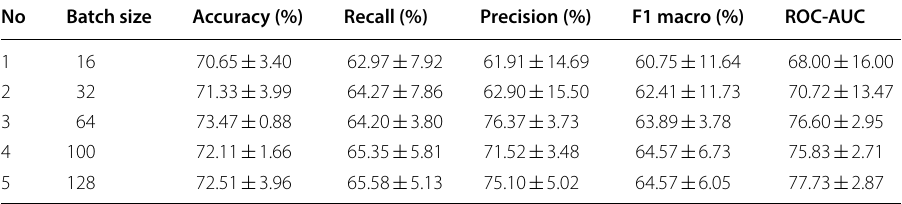
Table 8 Result of argument analysis using hierarchical attention network (FastText Word